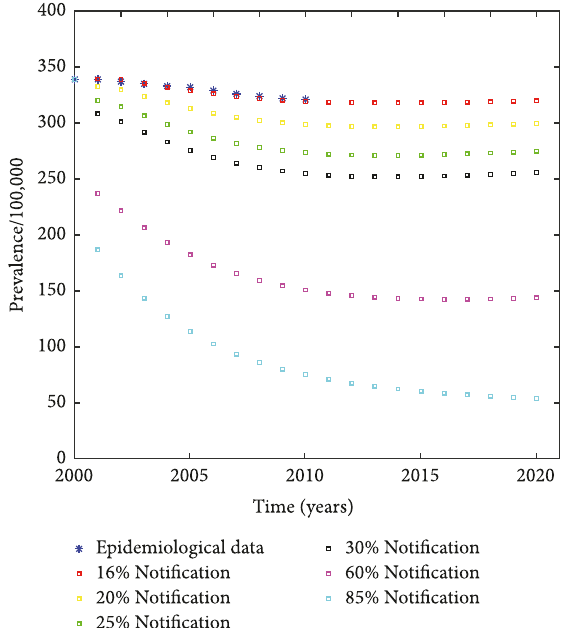
Figure 3: Hypothesis 1: baseline simulation and effect of the notifica- tion rate. Model fitted to the prevalence of tuberculosis in Nigeria. The blue star represents the epidemiological data of tuberculosis prevalencewhile thered line-circlerepresentsthemodel simulation. The fitting was done with 16% of the sick population being notified. The experiment was repeated with 20% (yellow curve), 25% (green curve), 30% (black curve), 60% (magenta curve), and 85% (cyan curve) notification,